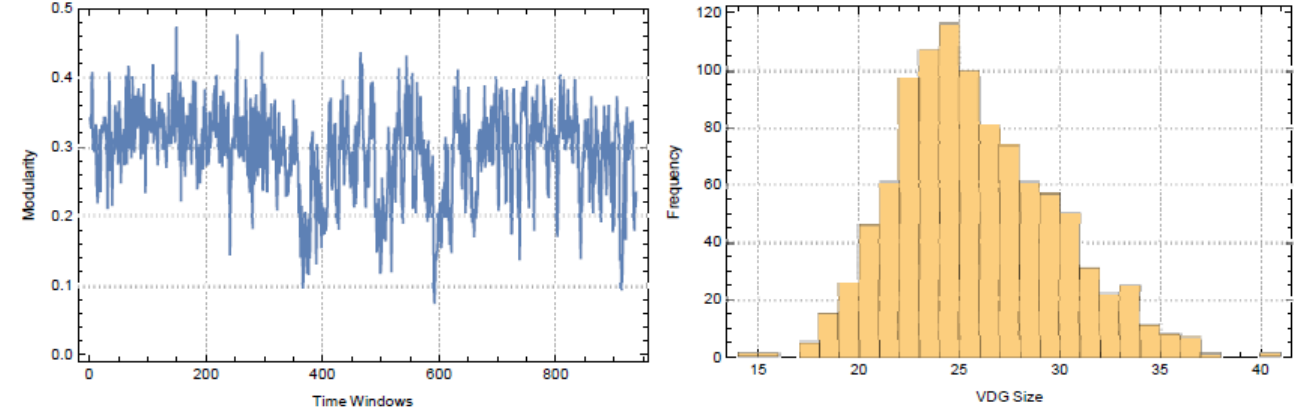
Figure 9. 𝒬 (cid:3037) measures and sizes of coarse graining of 𝐺 (cid:3021)(cid:3037) for Nasdaq-100.